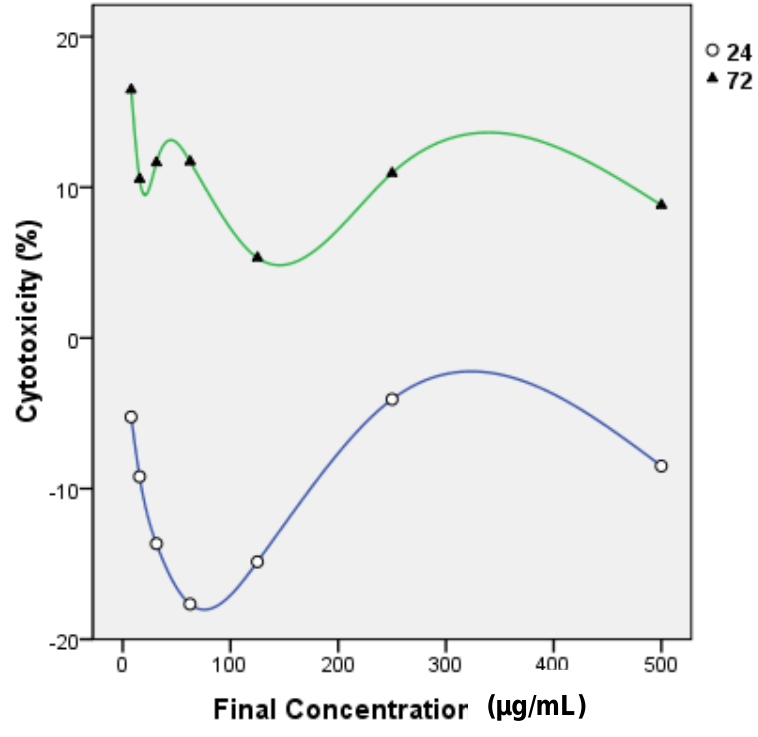
Figure 5. Effects of concentration and treatment time (24 h and 72 h) on cytotoxicity activity of leaf extract of L. camara assessed by MTT assay.